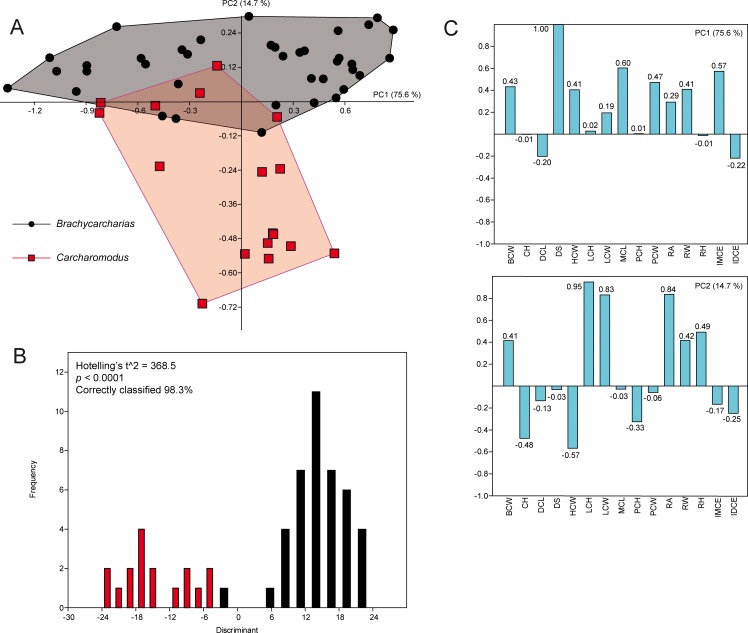
PCA.Results of the PCA performed on the standardized and log-transformed measurements for Brachycarcharias and Carcharomodus. (A) Morphospace plotted on PC1 and PC2; (B) Discriminant analysis results; (C) Loading values showing the variables associated with the two PC axes.